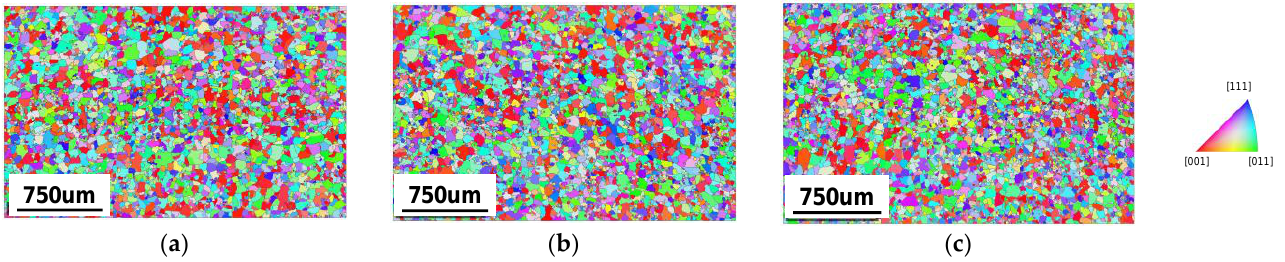
Figure 4. EBSD IPFX images for samples heated to different temperatures: ( a ) 300 °C, ( b ) 350 °C and ( c ) 400 °C at a heating rate of 1 °C/s before deformation.